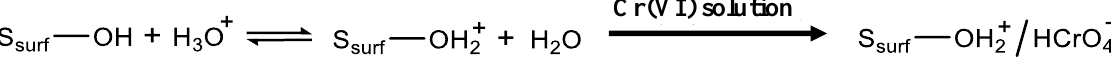
Figure 9. Absorption spectra of Cr(VI) adsorbed on silica-based xerogel at different initial concen- trations (mg/L) from 36.53 to 269.20 mg/L.